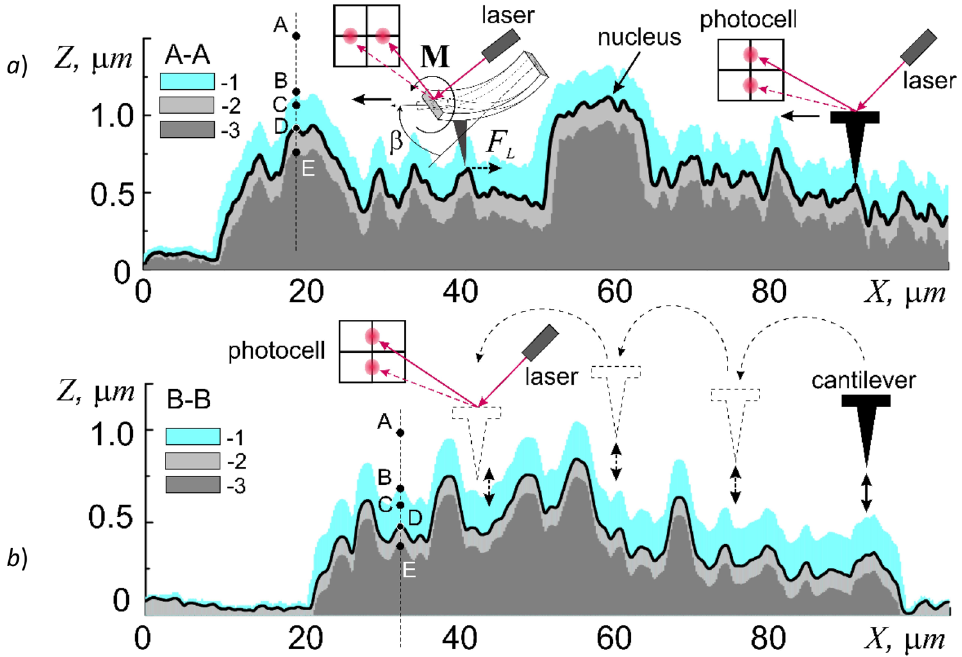
Figure 2. Profiles of cross-sections A–A and B–B shown in Fig. 1a of a buccal cell of human epithelium (1— adsorption layer, 2—elastic area, and 3—plastic deformation area). Schematic representations of the principles of AFM operation: contact ( a ), and hybrid ( b ) scanning